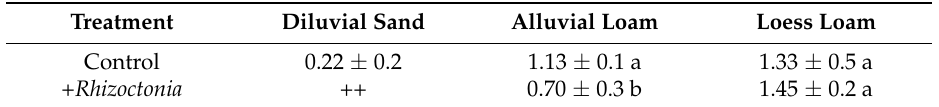
Table 1. Shoot dry mass (g plant − 1 ) of Lactuca sativa L. cv. Tizian grown on three different soils without (control) and with inoculation of Rhizoctonia solani AG1-IB (+ Rhizoctonia ). (++ Plants died within the first week after Rhizoctonia solani inoculation).